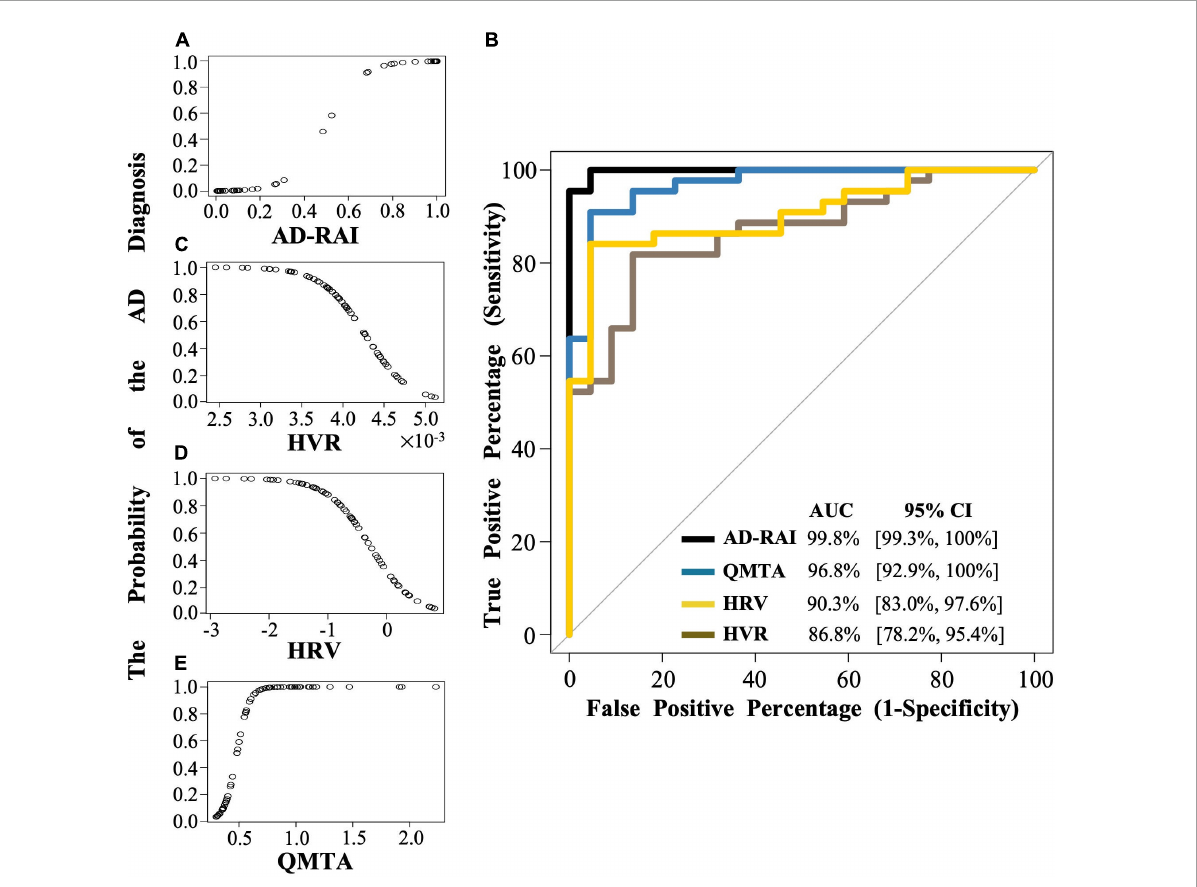
FIGURE2 The logistic regression modelling and the ROC curves for AD-RAI, HVR, HRV and QMTA. (A,C,D,E) Each dot indicates the predicted probability of an AD diagnosis given baseline AD-RAI, HVR, HRV or QMTA. (B) The black line, brown line, yellow line, and blue line represent the ROC curve of AD-RAI, HVR, HRV and QMTA, respectively. The ROC curve was plotted with the true positive percentage (TPP) on y -axis against the false positive percentage (FPP) on x -axis, which represent the sensitivity and (1-specificity), respectively, at all the decision thresholds and were calculated based on the logistic regression modelling and the MMSE-based reference diagnosis. The diagonal line shows where the TPP is the same as the FPP. The AUC represent the area under the curve measuring the overall performance of the model to diagnose the AD. AD, Alzheimer’s disease; AD-RAI, Alzheimer’s disease-resemblance atrophy index; AUC, area under the curve; HVR, hippocampal volume ratio; HRV, hippocampal residual volume; QMTA, quantitative temporal lobe atrophy; ROC, receiver operating characteristic; MIRIAD, Minimal Interval Resonance Imaging in Alzheimer’s Disease.